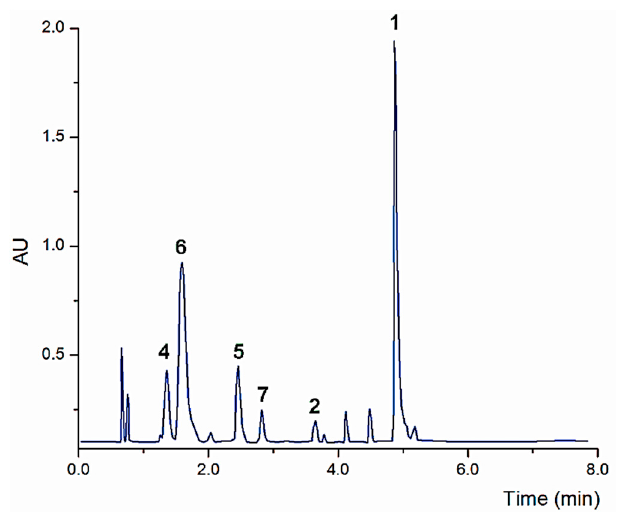
Figure 5. Representative LC chromatogram of the ethyl acetate soluble fraction prepared from the infusion of S. amarissima (Detection: 270 nm). Peak identification: 4 : R T 1.36 min; 6 : R T 1.60 min; 5 : R T 2.46 min; 7 : R T 2.82 min; 2 : R T 3.65 min; 1 : R T 4.89 min.